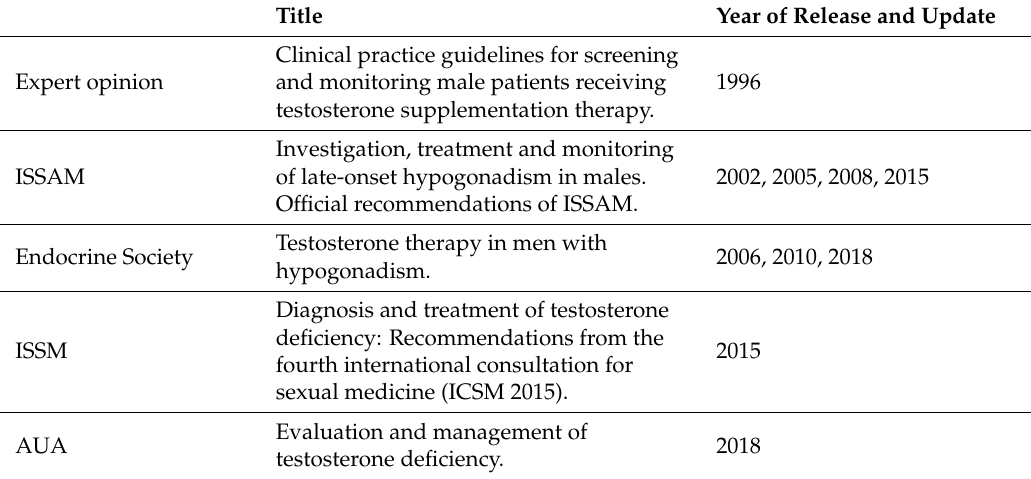
Table 1. Evolution of guidelines for diagnosis and treatment of testosterone deficiency syndrome